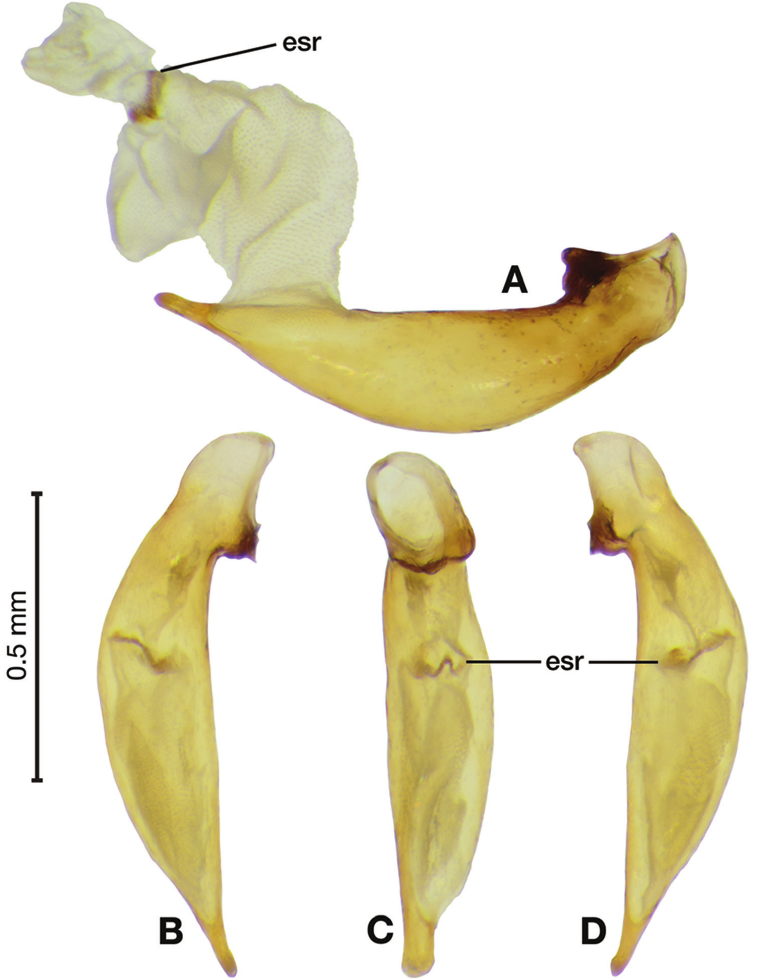
Figure 56. Digital images of male genitalia of C. ( Coptoderina ) taiwana (Nakane). A left lateral aspect, endophallus everted B right lateral aspect C ventral aspect D left lateral aspect. Legend: esr endophallus sclerite